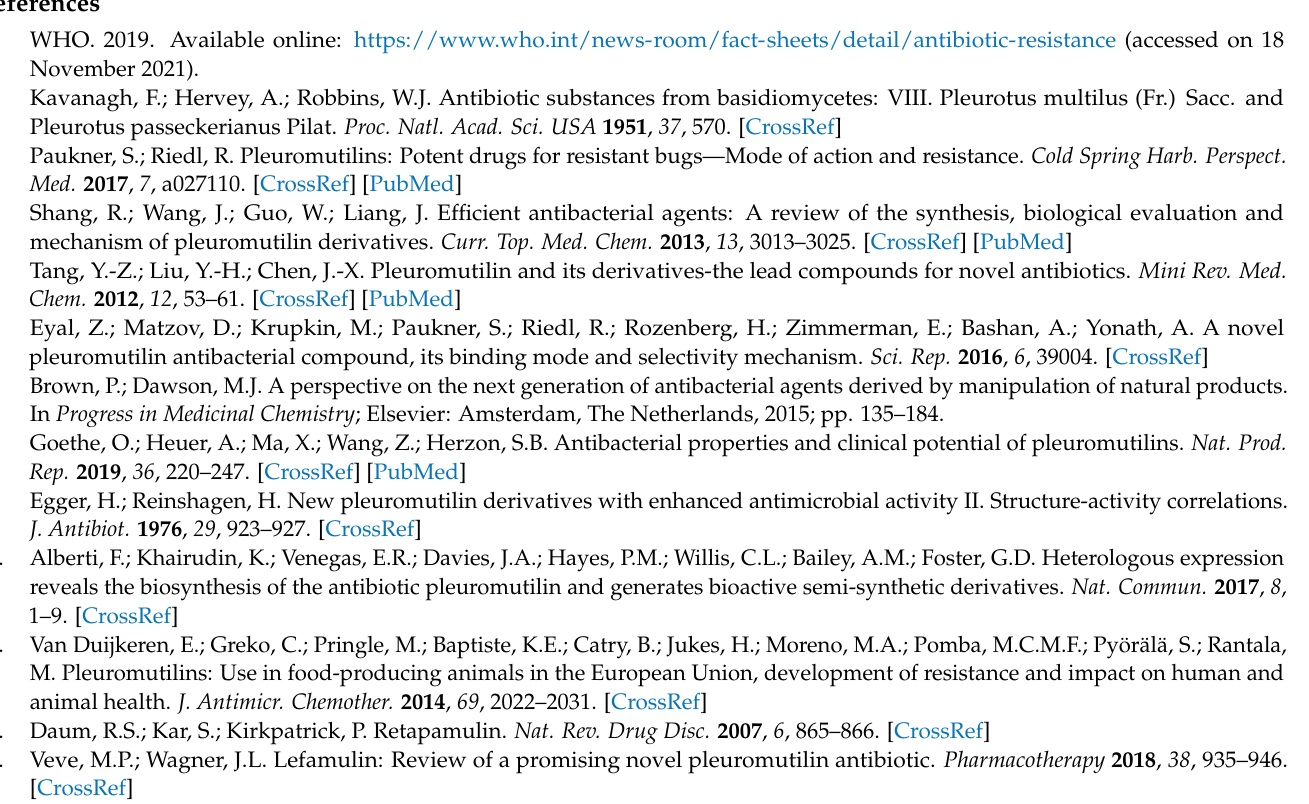
13 C NMR spectrum (400 MHz, MeOD) of compound 11g . Figure S20: 1 H and 13 C NMR spectrum (400 MHz, DMSO) of compound 11h . Figure S21: 1 H and 13 C NMR spectrum (400 MHz, MeOD) of compound 11l . Figure S22: 1 H and 13 C NMR spectrum (400 MHz, CDCl 3 ) of compound 13a . Figure S23: 1 H and 13 C NMR spectrum (400 MHz, CDCl 3 ) of compound 13b . Figure S24: 1 H and 13 C NMR spectrum (400 MHz, DMSO) of compound 14h . Figure S25: 1 H and 13 C NMR spectrum (400 MHz, DMSO) of compound 14j . Figure S26: 1 H and 13 C NMR spectrum (400 MHz, DMSO) of compound 14k . Figure S27: 1 H and 13 C NMR spectrum (400 MHz, DMSO) of compound 15h . Figure S28: The experimental setup for carrying out hydrothiolation reactions at low temperature. Figure S29: ESI-MS spectrum of compound 10j . Figure S30: MALDI-MS spectrum of compound 10k . Figure S31: Calibrated MALDI-MS spectrum of compound 10k . Figure S32: MALDI-MS spectrum of compound 11h . Figure S33: Calibrated MALDI-MS spectrum of compound 11h . Figure S34: ESI-MS spectrum of compound 14j . Figure S35: MALDI-MS spectrum of compound 14k . Figure S36: Calibrated MALDI-MS spectrum of compound 14k . Figure S37: ESI-MS spectrum of compound 15h